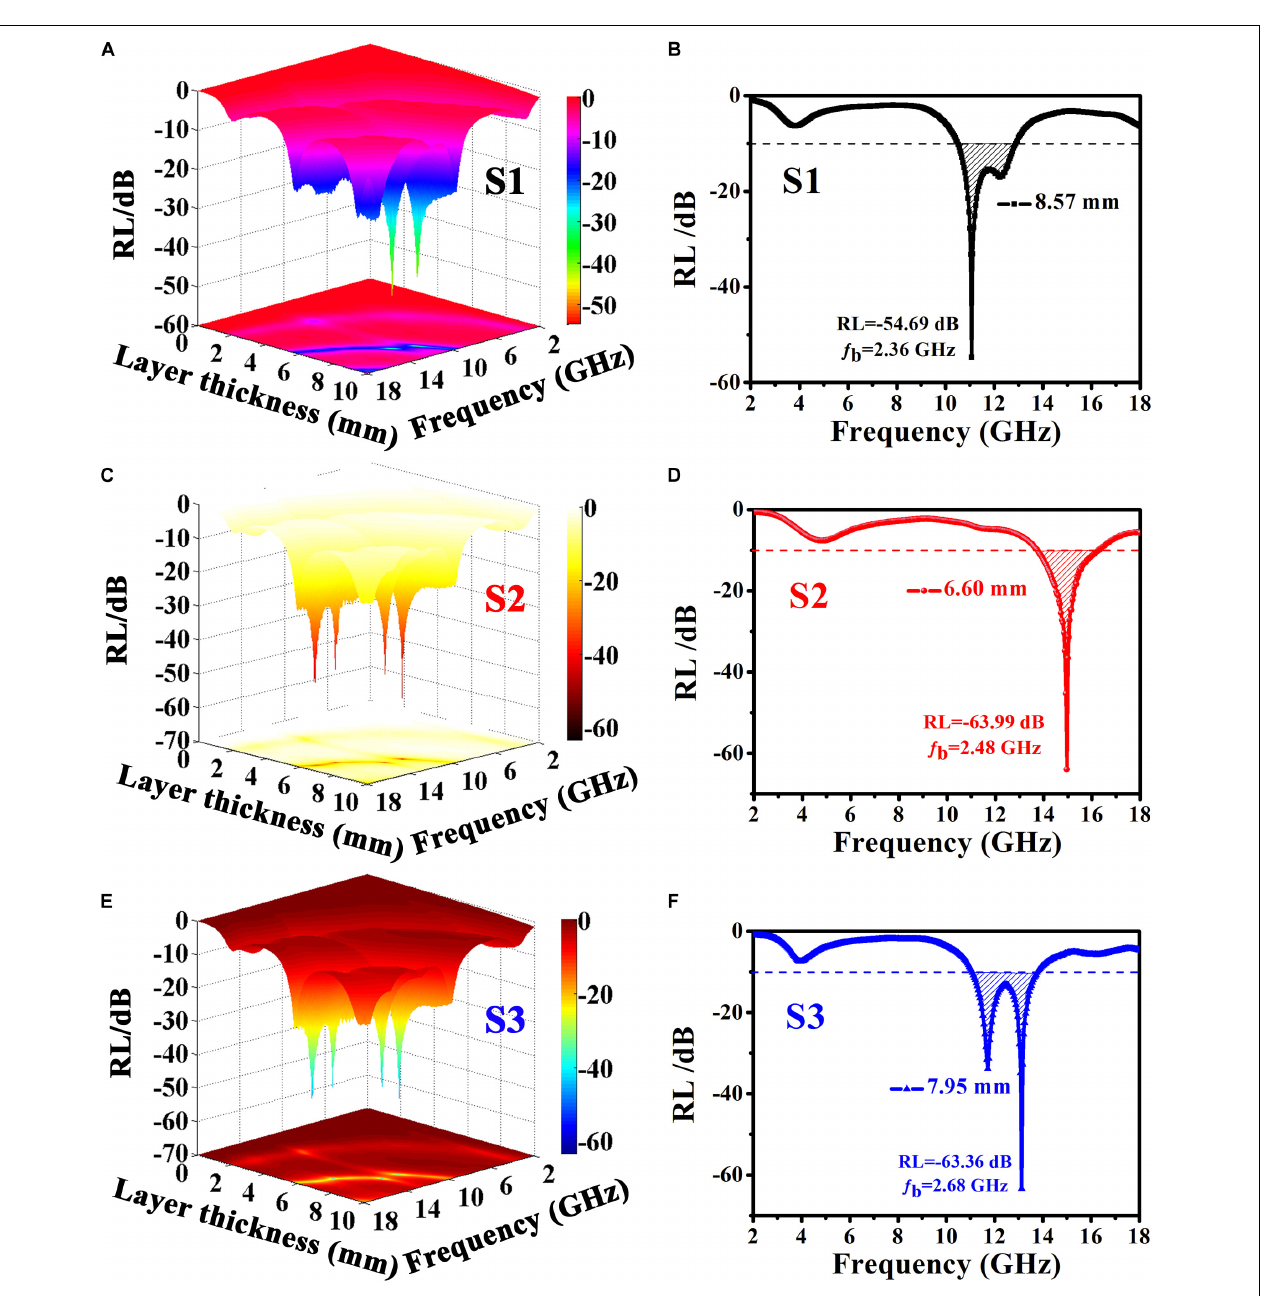
FIGURE 7 | 3D color RL curves and their corresponding RL min plots of (A,B) S1, (C,D) S2, and (E,F) S3.